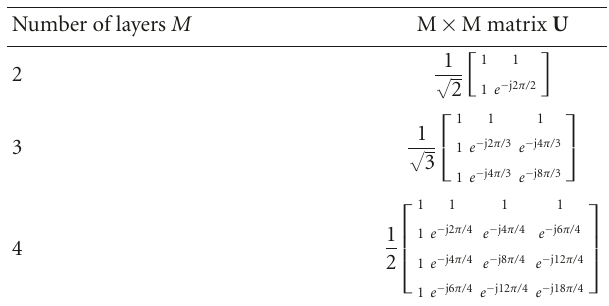
Table 4: DFT precoding matrix U .